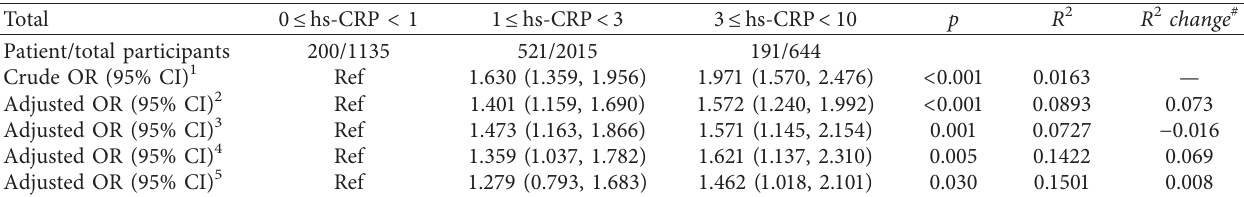
Table 4: Multivariable-adjusted odds ratios of hypertension according to categories of hs-CRP in follow-up studies from 2009 to 2015 ( n �